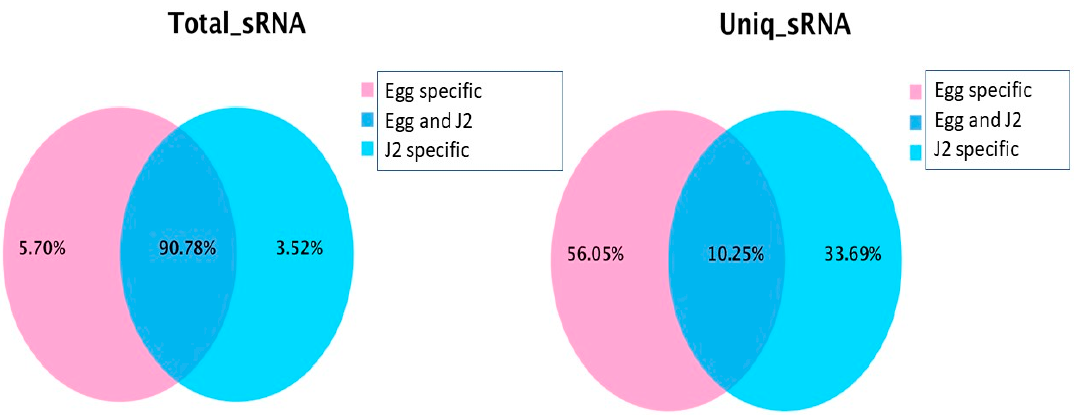
Figure 1. Sequence comparison between eggs (Pink) and J2 larvae (Blue). ( Left ): total clean reads; ( right ): the unique small RNA sequences.